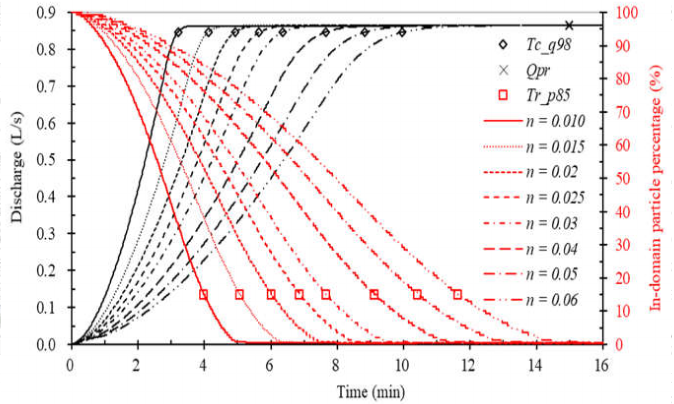
Figure 4. Simulated outlet discharge and in-domain particle percentage versus time under different roughness ( n ) coefficients for eight modeling cases with i = 88.9 mm/h, S 0 = 0.005, and L = 35 m of impervious